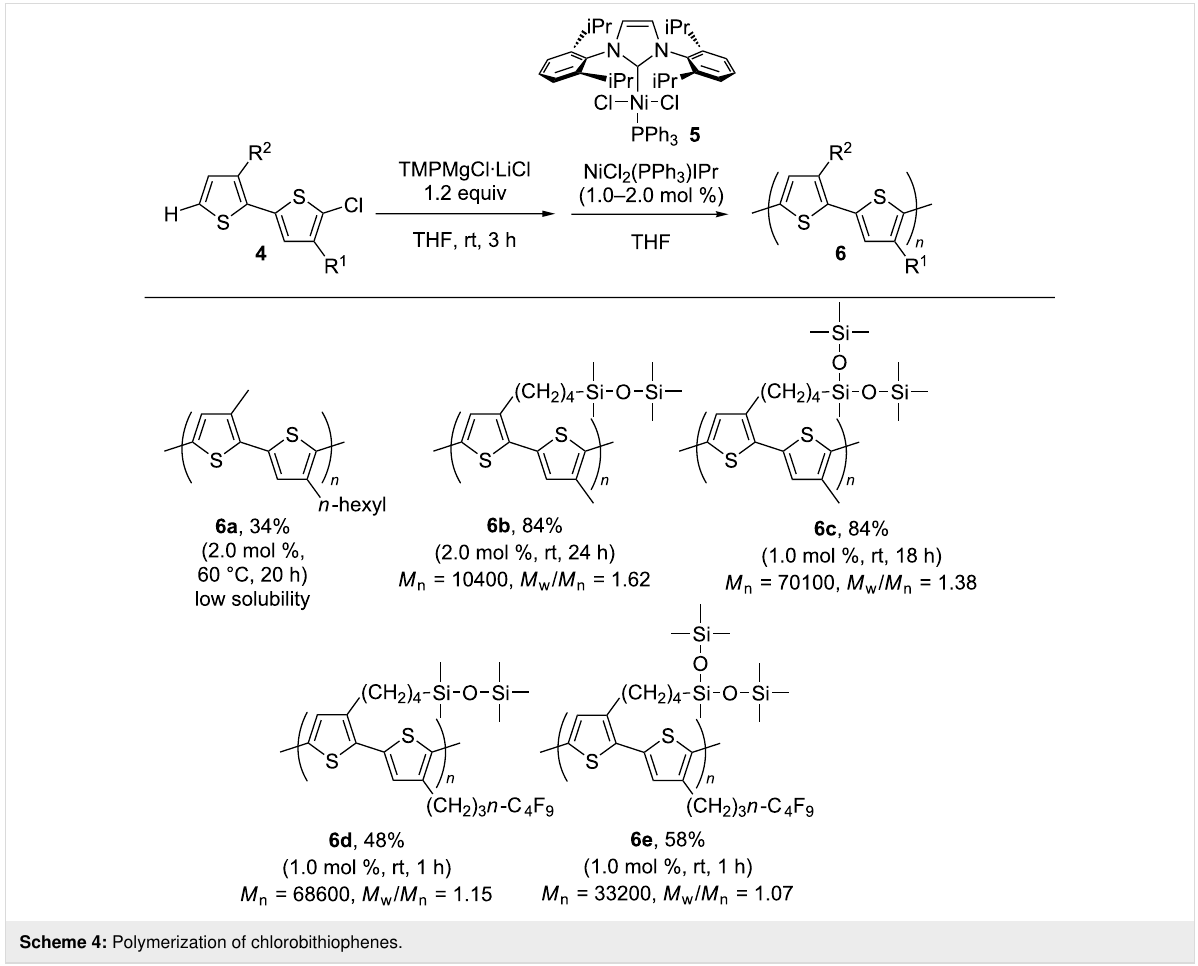
Scheme 4: Polymerization of chlorobithiophenes.